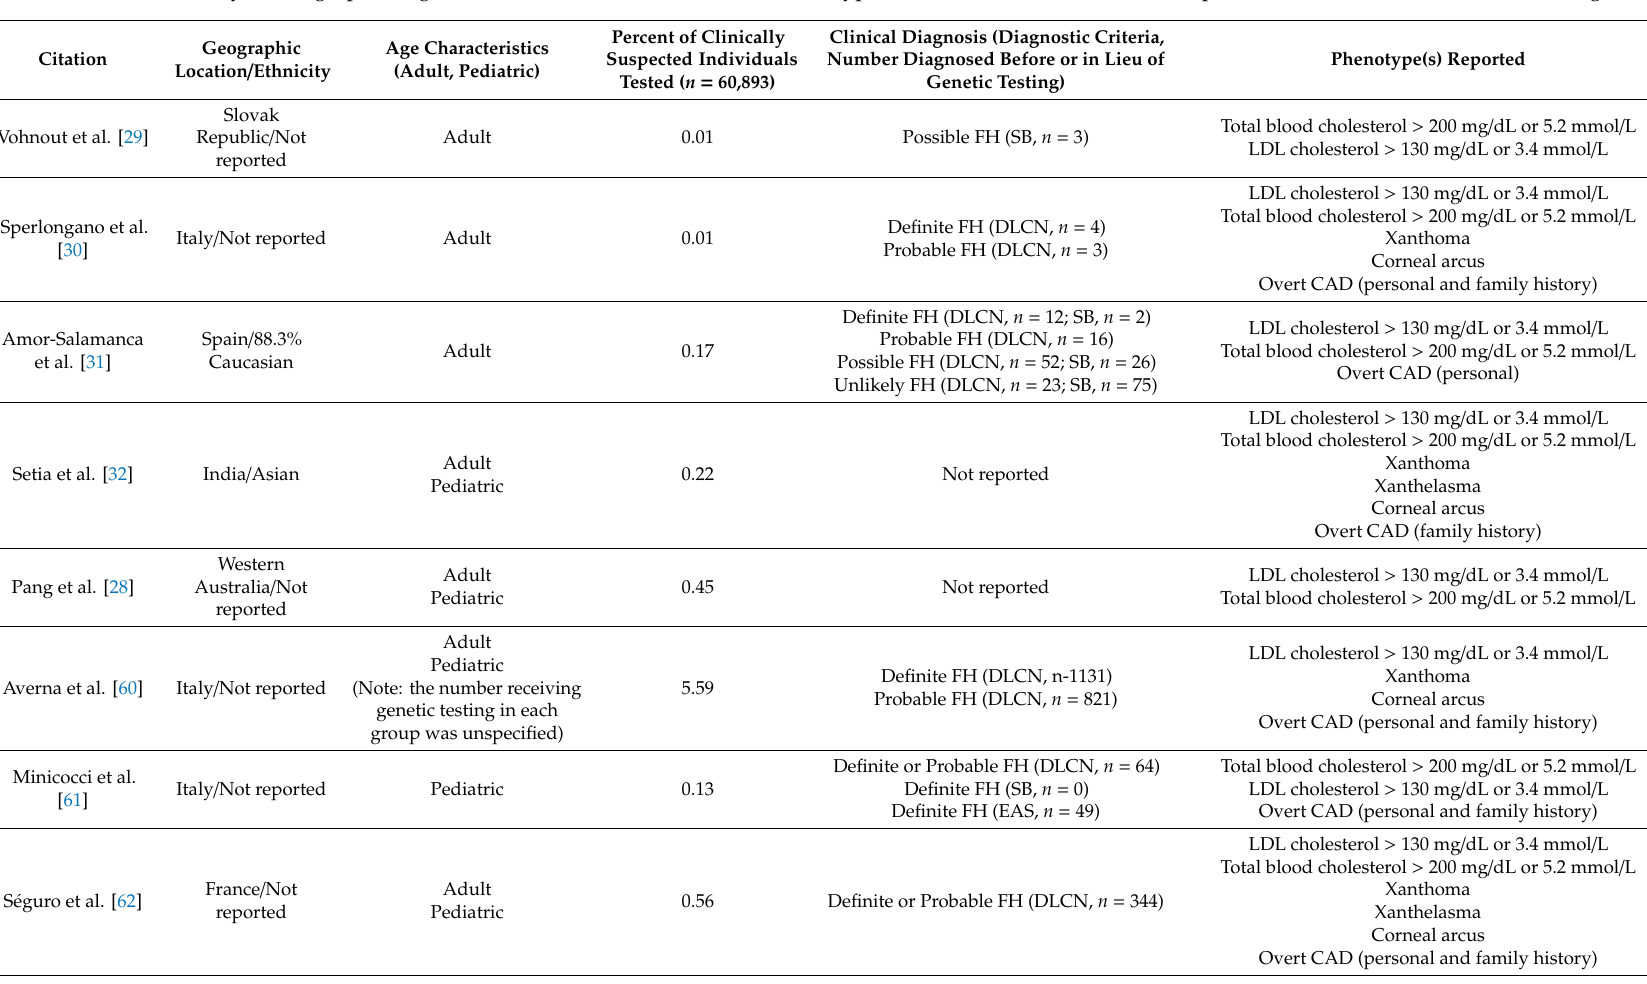
Table A1. Summary of Geographic, Age, and Clinical Characteristics: Familial Hypercholesterolemia (FH) Patient Populations Who Received Genetic